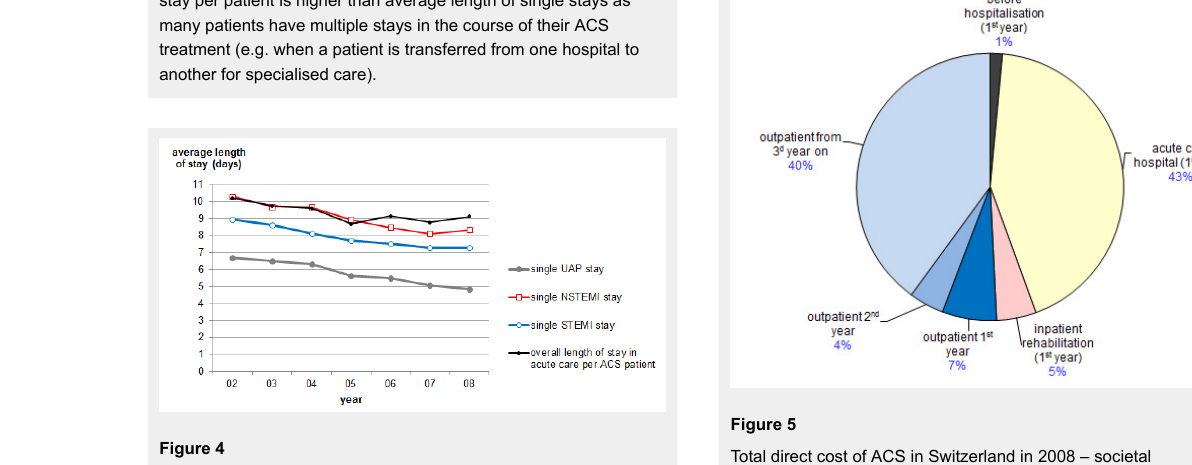
Total direct cost of ACS in Switzerland in 2008 – societal perspective (%). Own calculation on the basis of a variety of